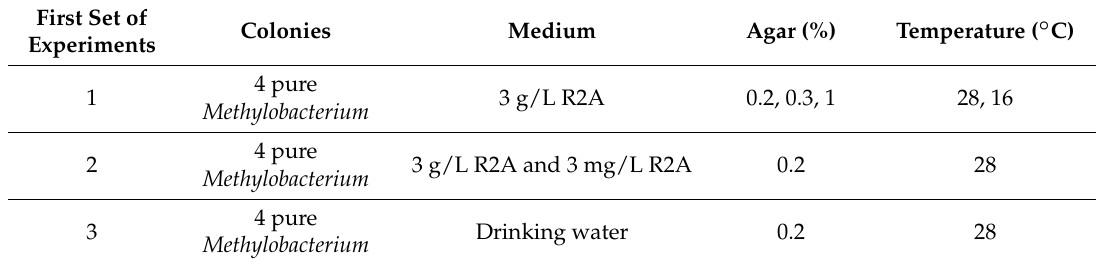
Table 1. Summary of conditions of the first set of